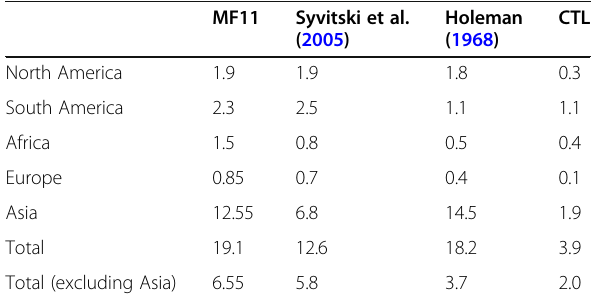
Table 6 Comparison between previous estimates and CTL of continental-scale suspended sediment flow [Bt/a]